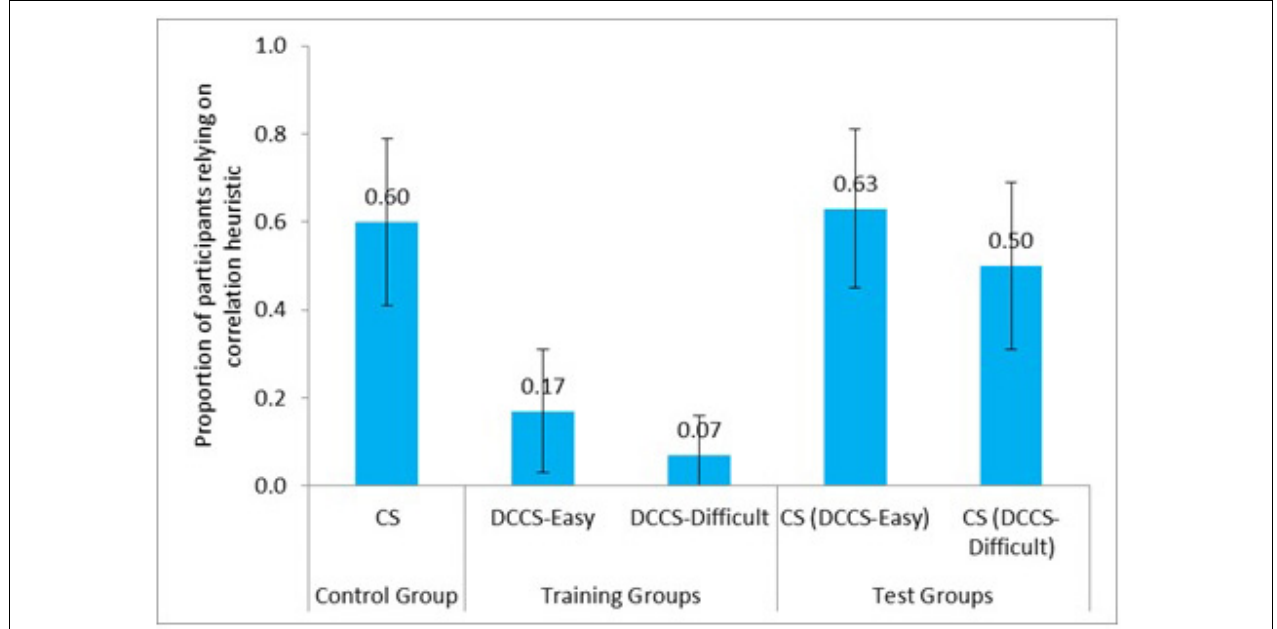
FIGURE 10 | Proportion of participants relying on correlation heuristic in three conditions: DCCS-Easy, DCCS-Difficult, and CS conditions. The CS (DCCS-Easy) task and CS (DCCS-Difficult) task refer to CS tasks following the DCCS performance in the DCCS-Easy and DCCS-Difficult conditions. The error bars represent 95% confidence interval around the point estimate.